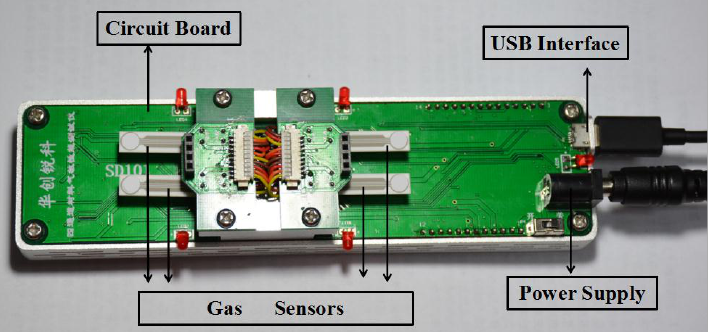
Figure 2. The SD-101 gas sensing performance testing device.